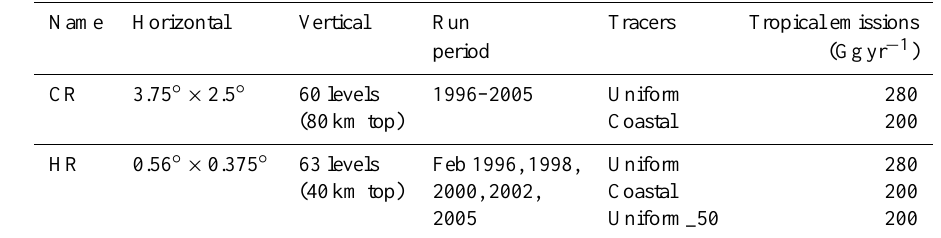
Table 1. Characteristics of models and simulations.